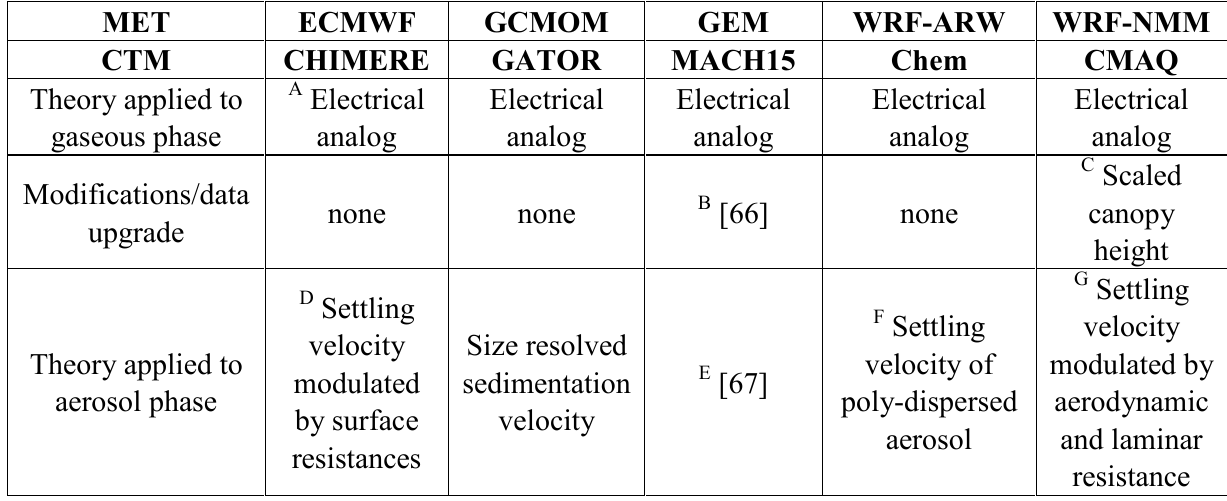
Table 3. Same as for Table 2, except that the case of dry deposition schemes is